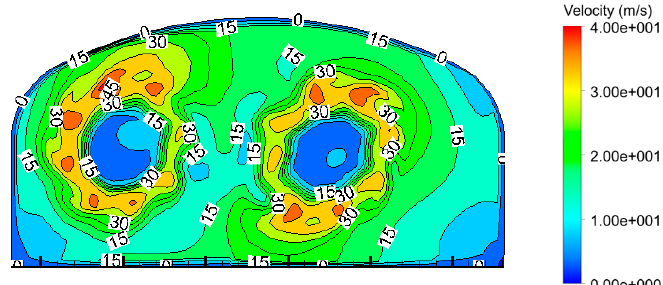
Figure 14. Velocity contour at the position of fans’ exits.